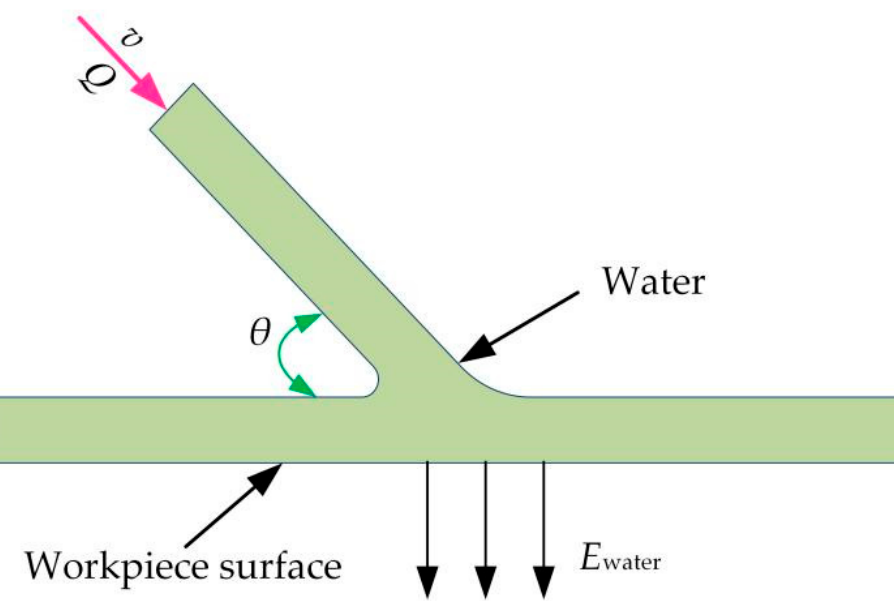
Figure 2. Schematic diagram of water impact workpiece .